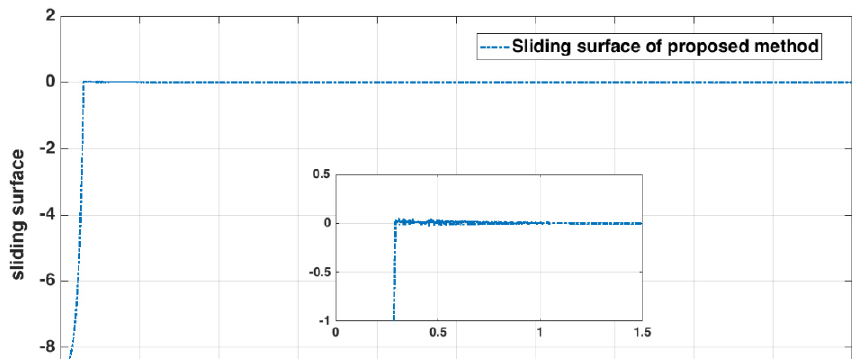
Figure 20. Control signal u ( t ) .